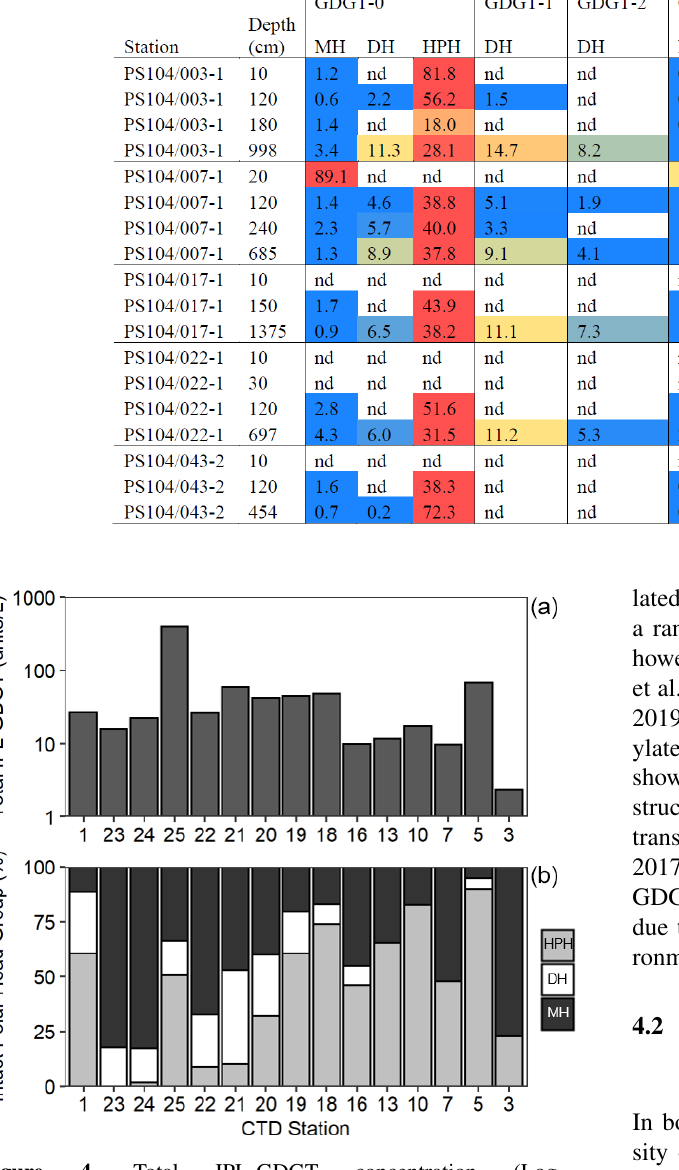
Figure 4. Total IPL-GDGT concentration (Log 10 , unitsL − 1 ) (a) and relative abundance (%) of IPL-GDGT head groups, monohexose (MH, black), dihexose (DH, white), and hexose-phosphohexose (HPH, grey) (b) in Scotia Sea thermocline samples (mixed layer samples excluded from